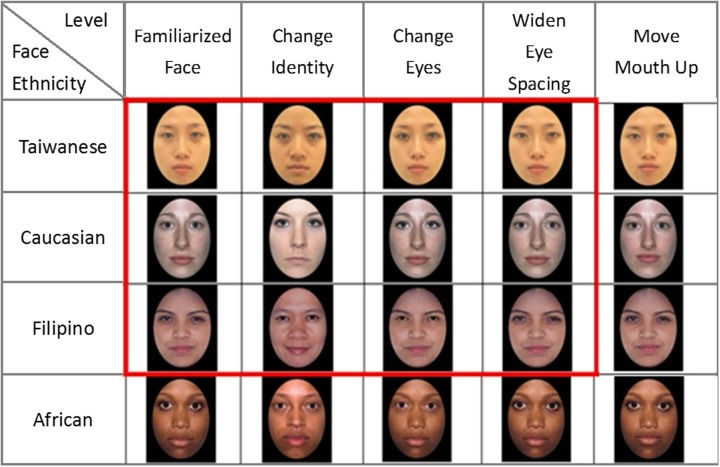
The face stimuli used in the adult experiment and a subset of the stimuli used in the infant experiment (indicated with the red frame). The stimuli contained female/male faces of four ethnic groups (Taiwanese, Caucasian, Filipino, and African) only female faces are shown here. Four levels of difficulty in stimulus discriminability are adopted: the “change identity,” “change eyes,” “widen eye spacing,” and “move mouth up” conditions.